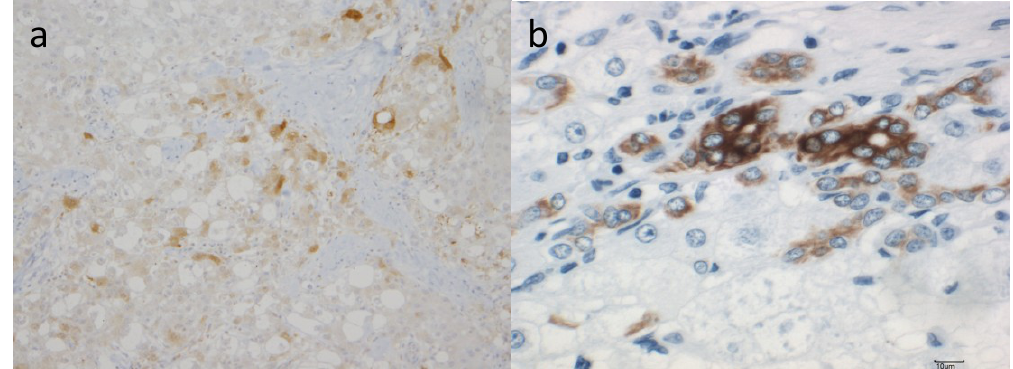
Figure 3. Immunostaining of NASH-derived HCC: ( a ) NASH-derived HCC cells with cytoplasmic reactivity to the MMP-9 antibody are scattered sparsely throughout the nodule (100× magnification); ( b ) NASH-derived HCC cells with cytoplasmic reactivity to the CK19 antibody are also seen (400×